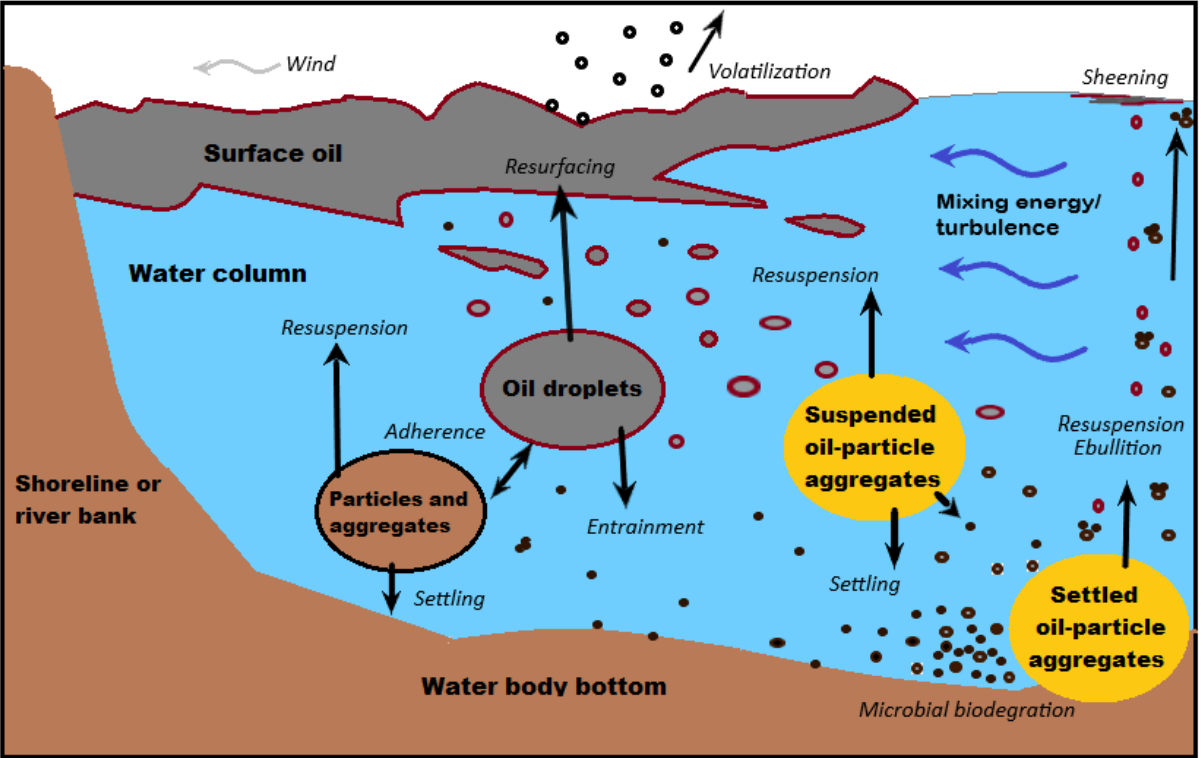
Figure 14. Simplified diagram of the processes and mechanisms leading to oil-particle aggregate formation and breakup in marine and freshwater environments. Modified from Fitzpatrick et al. [167].